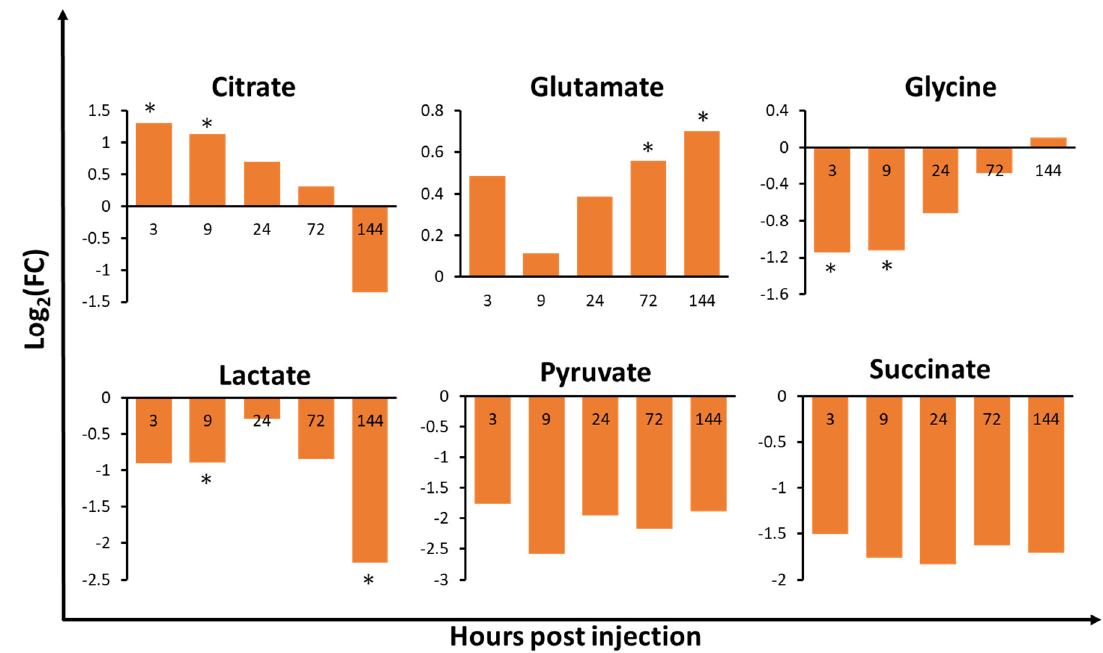
Figure 5. Fold change of relative metabolite concentrations in the haemolymph of whiteleg shrimp infected with Vibrio harveyi when compared to 0 hpi in the control group. Values with an asterisk (*) indicate significant differences between the control and infected group ( p < 0.05) ( n = 3).